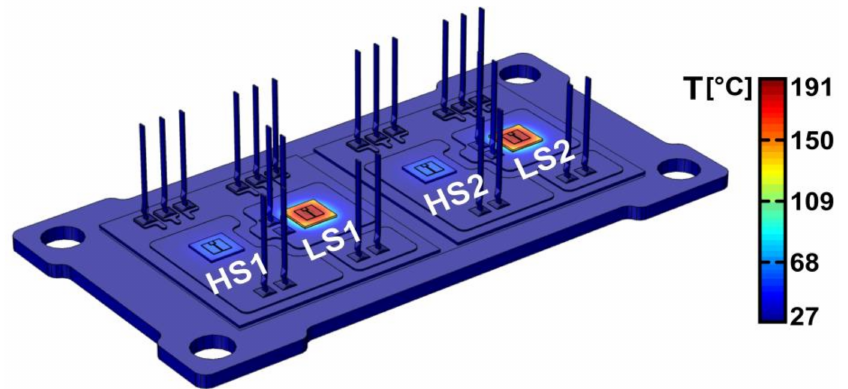
Figure 10. Nonlinear-corrected spatial temperature distribution in the PM extracted by FANTASTIC in a post-processing stage, corresponding to the time instant t = 800.0 ms of the DC-DC converter simulation. The insulating gel is set as transparent for illustrative purposes. The location of LS and HS devices is also highlighted.